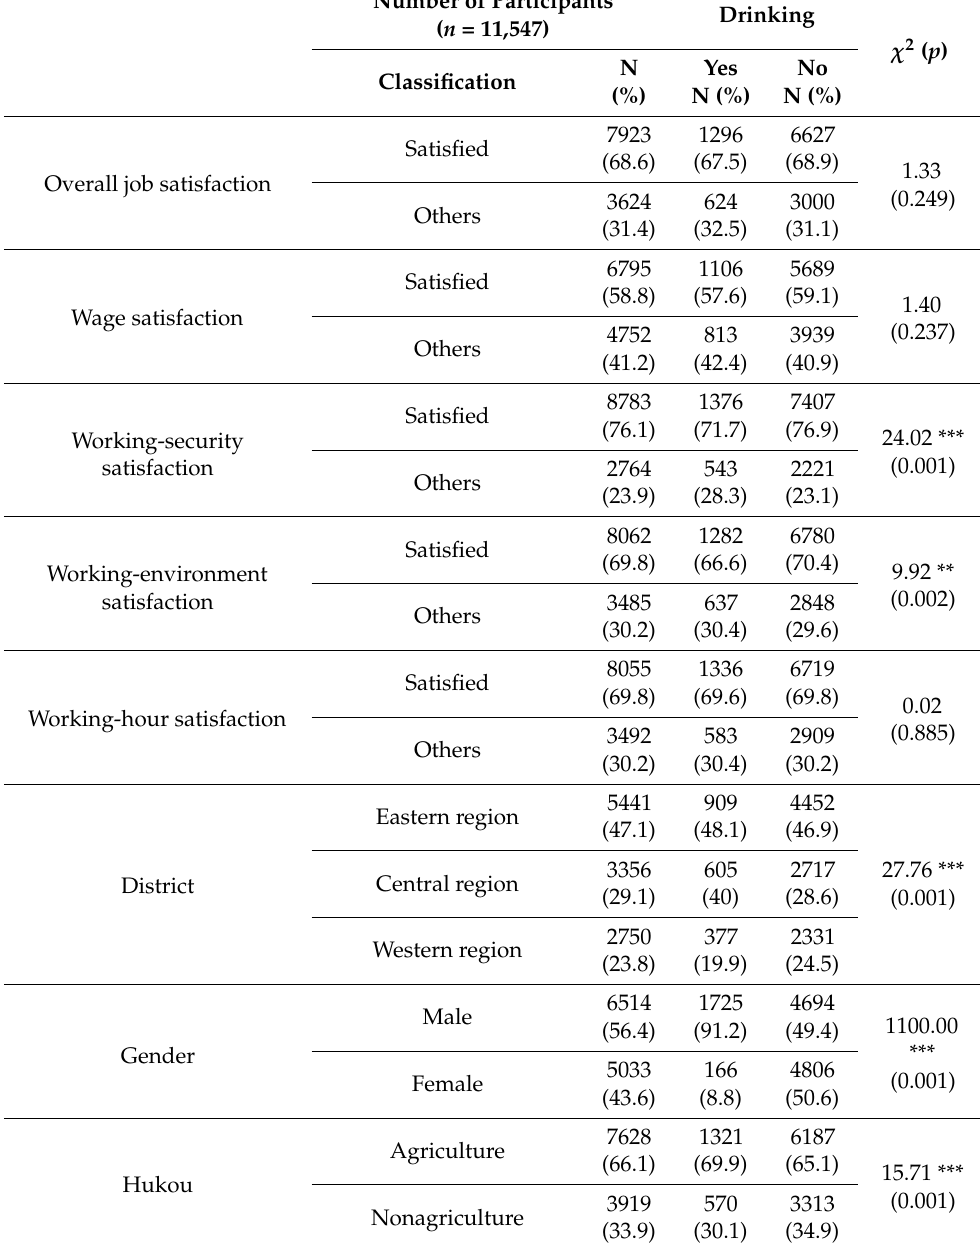
Table 1. Distribution of general